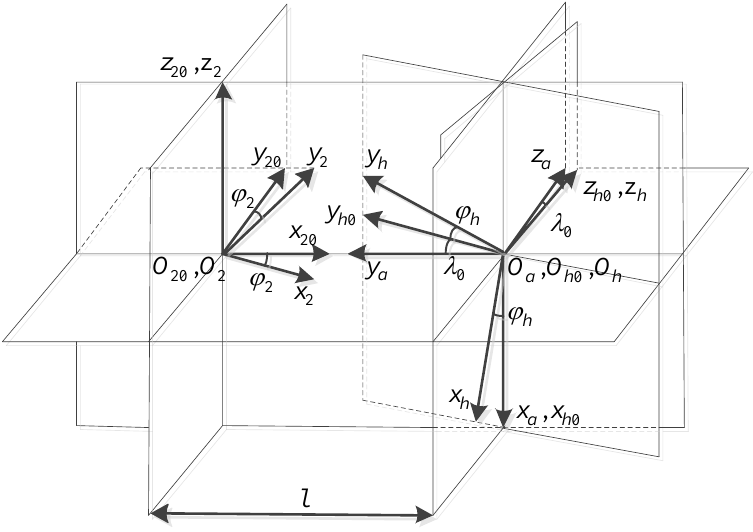
Figure 3. The coordinate system of face-gear honing.